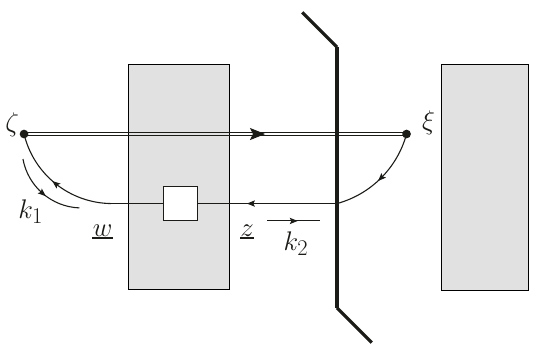
Figure 8. Diagram of class B with kinematics specified. The antiquark propagates from ζ with momentum k , undergoes a transverse spin dependent interaction with the proton at transverse 1 positions w and z before and after scattering, respectively, then propagates to ξ with momentum k 2 . The sub-eikonal interaction with the proton shock wave is denoted by the white